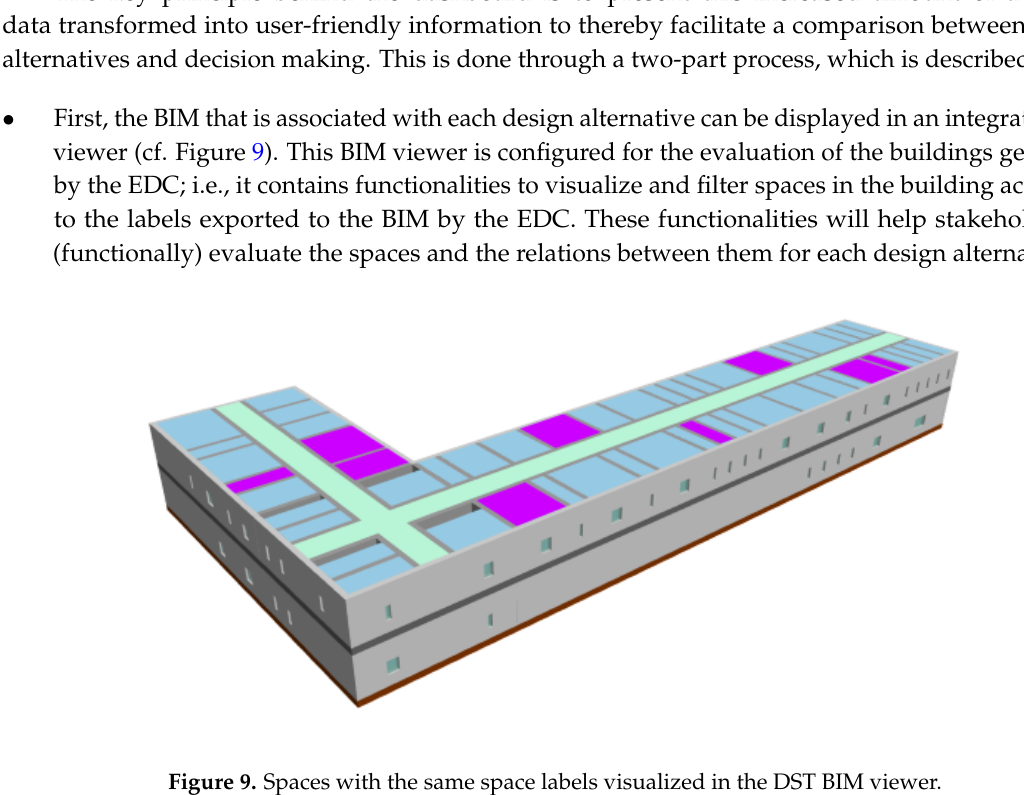
Figure 9. Spaces with the same space labels visualized in the DST BIM